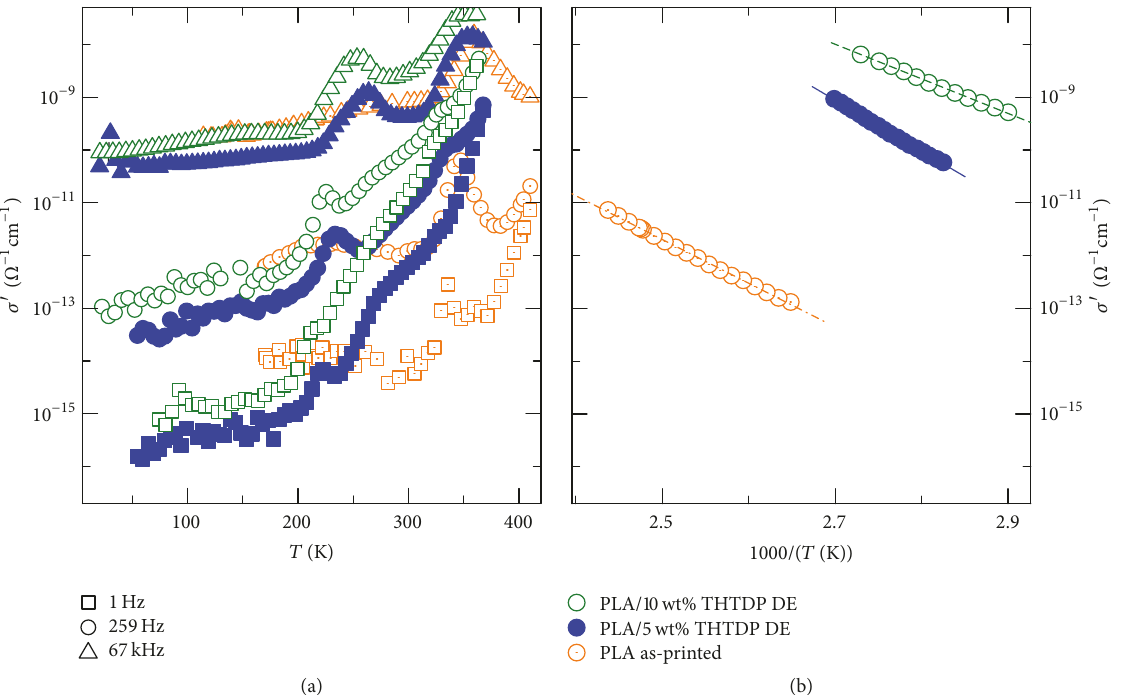
Figure5:(a)Temperaturedependentconductivityforselectedfrequenciesof5and10 wt%ILaddedPLAand“as-printed”PLA.(b)Arrhenius representation of evaluated dc-conductivities. Lines denote a thermally activated behaviour following an Arrhenius